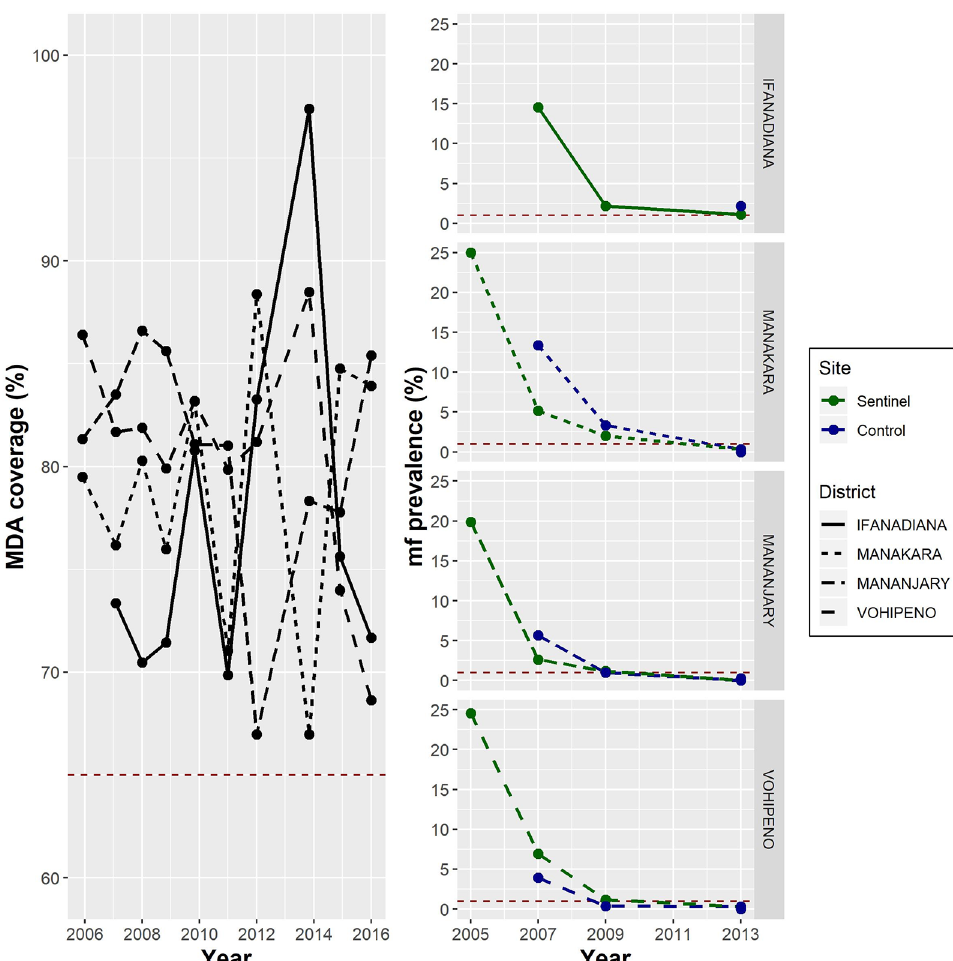
Fig 2. Evolution of lymphatic filariasis mf prevalence (right) and treatment coverage of mass drug administration (left) in four health districts of the region of Vatovavy Fitovinany, 2006–2016. Red dashed lines show threshold limits for eligibility to conduct a transmission assessment survey: 65% MDA coverage over 5 years and less than 1% mf prevalence in sentinel and spot check sites. Source : Madagascar Ministry of Health, National Programme for the Elimination of Lymphatic Filariasis. For mass drug administration (MDA) coverage estimations, uptake information in paper forms filled by schools and community health workers during MDA campaigns was aggregated by the head of the corresponding health centre, who calculated coverage using Ministry of Health population estimates for each administrative unit. These data were aggregated for each district by the National Programme. Selection of sentinel and spot-check sites and surveillance of mf prevalence in these sites was done strictly following WHO guidelines